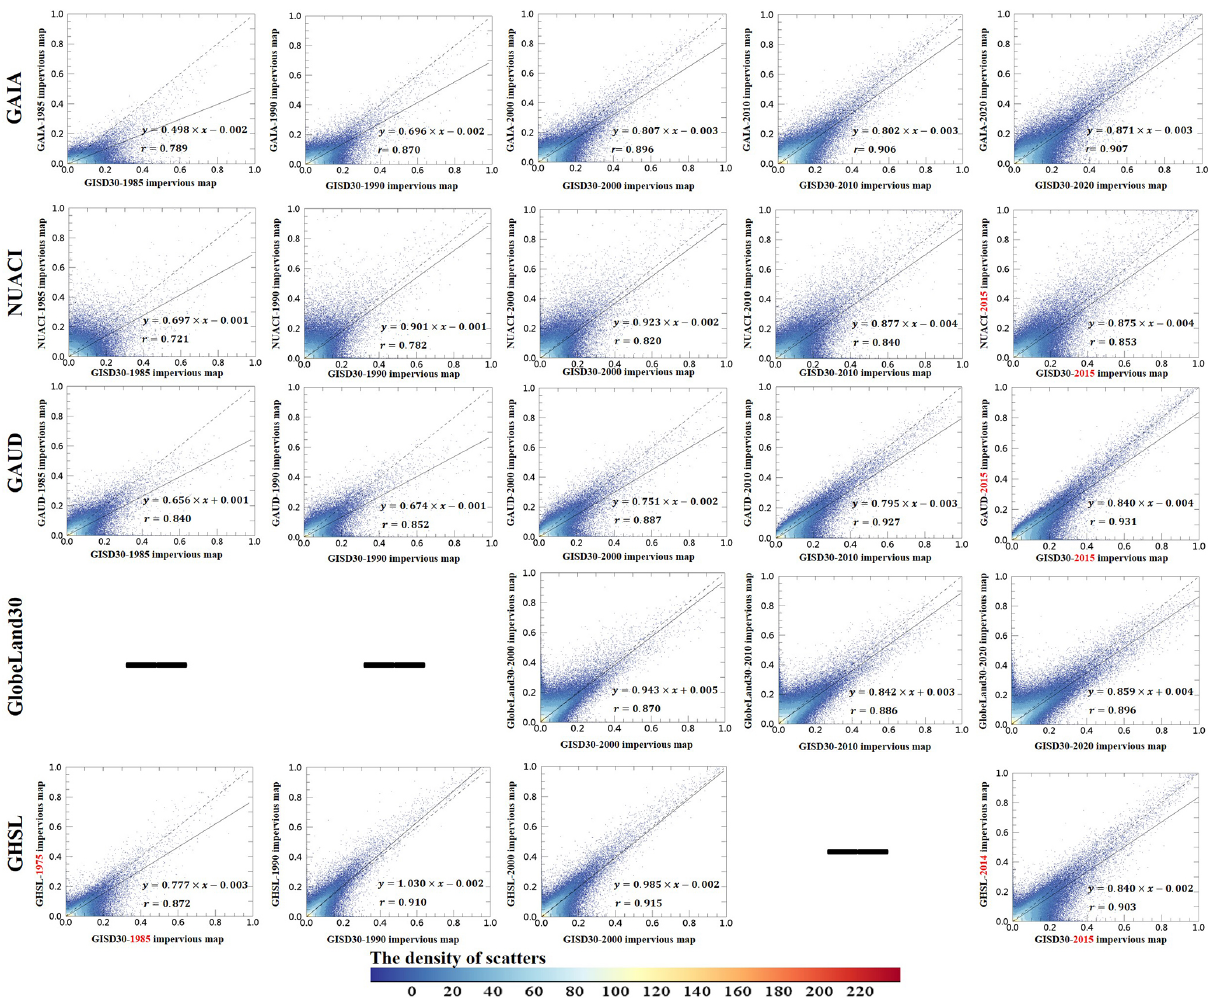
Figure 11. The scatterplots of the GISD30 dataset ( x axis) against five previous global 30m impervious-surface products ( y axis, GAIA, NUACI, GAUD, GlobeLand30 and GHSL datasets) at the spatial resolution of 0 . 05 ◦ × 0 . 05 ◦ . It should be noted that the label of the x and y axes was the proportion of impervious surfaces in each 0 . 05 ◦ × 0 . 05 ◦ spatial